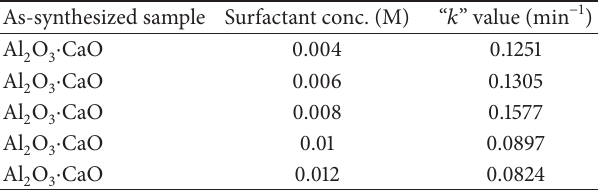
Table 2: Effect of surfactant concentration on catalytic activity of ⋅ CaO nanocatalysts prepared at 180 ∘ C under hydrothermal O Al 2 3